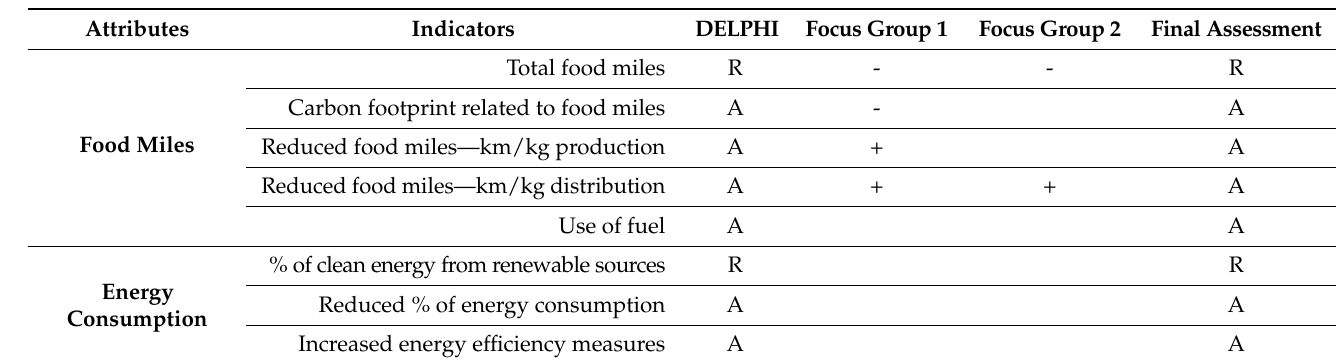
Table 3. Initial results of environmental attributes and